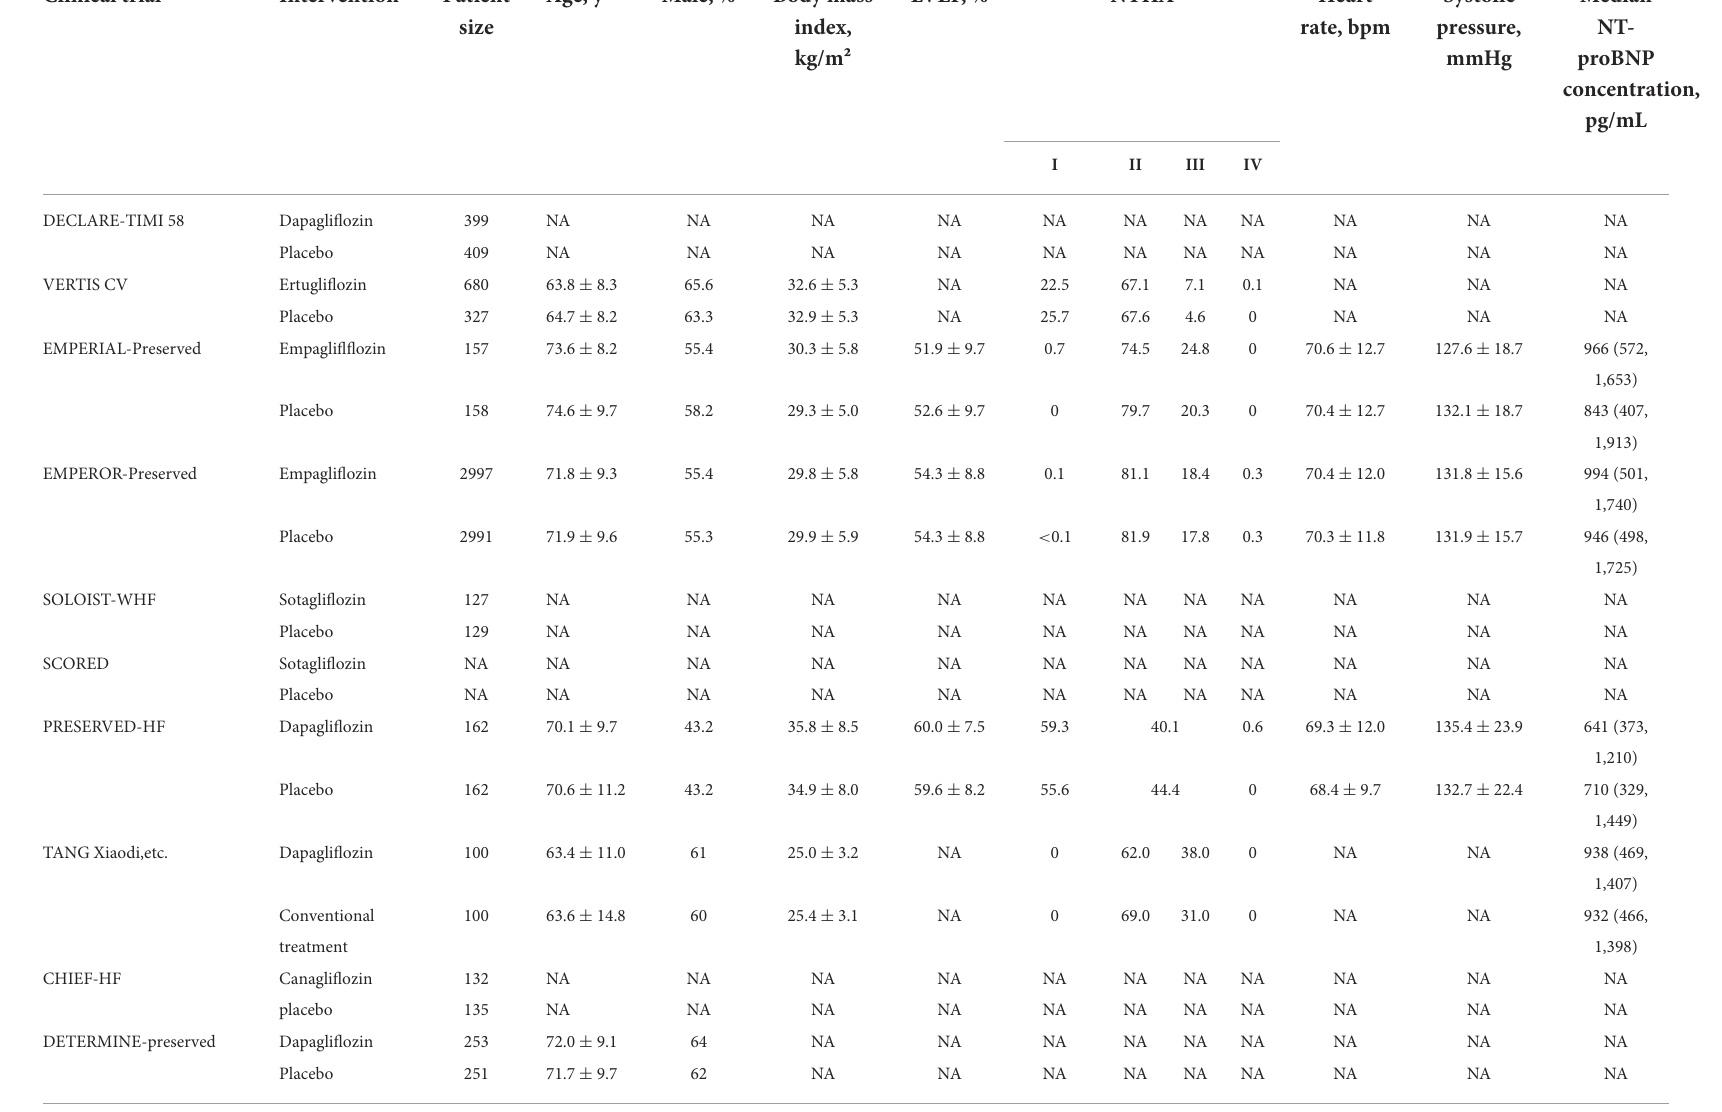
TABLE 1B Basal characteristics of included